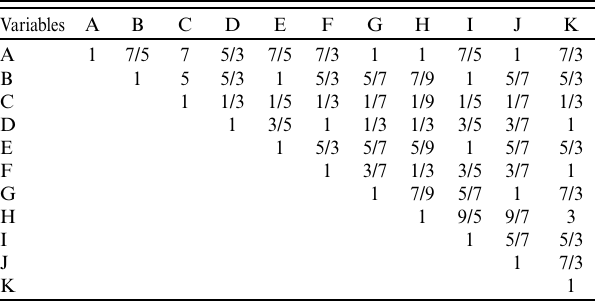
Table 5 . Pairwise comparison matrix for regional authority for the rapid development scenario Variables A